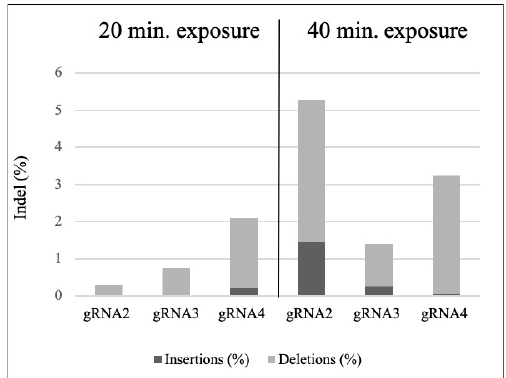
Figure 4. Frequency of mutations in maize protoplasts generated by CRISPR-Cas9 and measured by the Inference of CRISPR Editing Software—ICE software v.2. Different gRNAs and exposure time of the protoplasts to the RNP complex are represented. Percentages of insertions and deletions are represented in dark grey and light grey, respectively. Table 2. Mutation rates in Zea mays IPK gene target region produced by CRISPR-Cas RNP delivery and analyzed by Sanger sequencing and ICE software